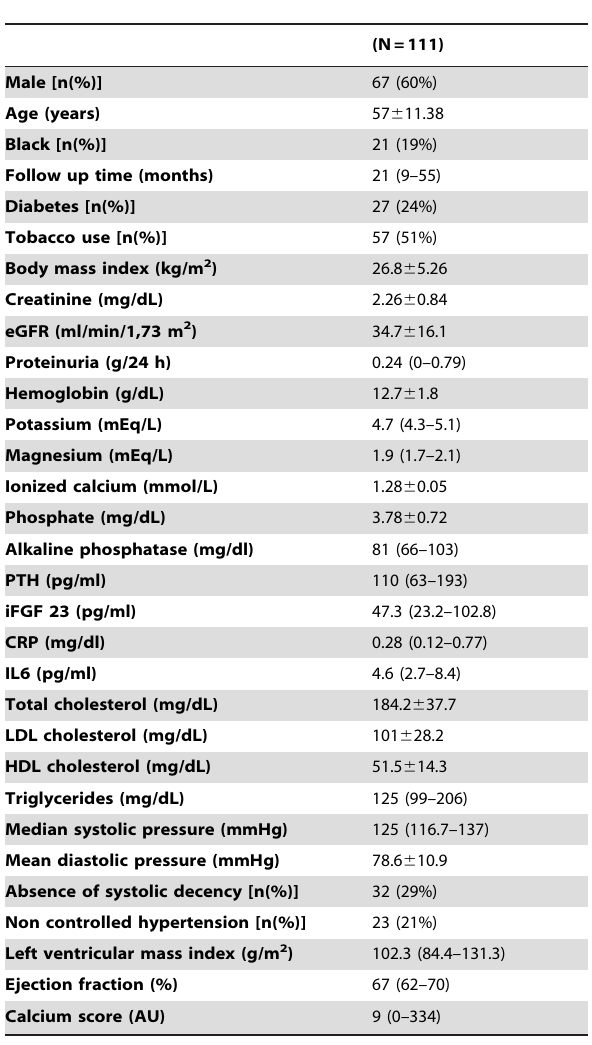
eGFR - estimated Glomerular Filtration Rate; iPTH - intact Parathyroid Hormone; FGF23 - Fibroblast Growth Factor 23; CRP - C-Reactive Protein; IL6 - Interleukin- 6. Results in mean 6 SD, median (interquartiles) or proportions. doi:10.1371/journal.pone.0066036.t001 PLOS ONE |